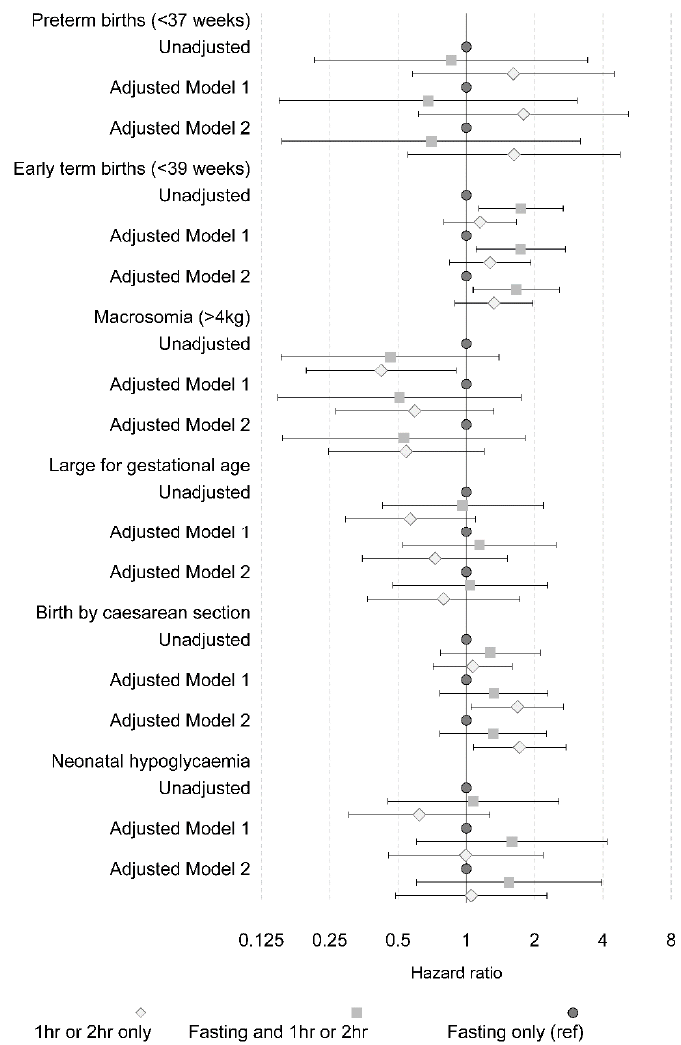
Figure 3. Representation of outcomes against glucose levels as a forest plot. * Adjusted for ethnicity (Caucasian, South Asian, South-East Asian, Other), birth year (in categories), parity (1, 2, 3+), maternal age (centred continuous), BMI (centred continuous). ** Adjusted as per model 1 and additionally including treatment type (diet, insulin, metformin, insulin and metformin).